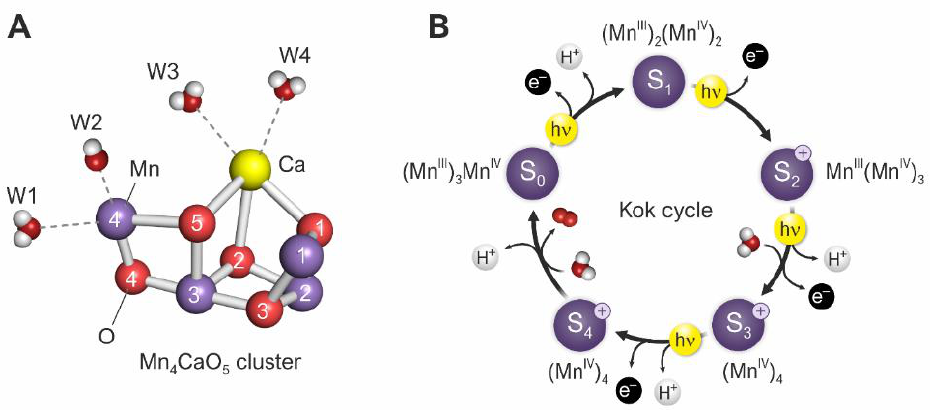
Figure 3. ( A ) The oxygen-evolving complex (OEC). The four manganese ions are colored violet, the six oxygen atoms are indicated in red, and the calcium atom is indicated in yellow. W1 to W4 are water molecules. ( B ) The Kok cycle (also called the Kok–Joliot cycle). S 0 to S 4 are the OECs in various states, without or with a positive charge, with oxidation states of the manganese indicated. Yellow circles labelled h ν indicate quanta from light. When S 2+ changes to S 3+ , a water molecule is taken up, and an electron and a proton are released. When S 3+ changes to S 0 , a water molecule is taken up, and a proton and an oxygen molecule are released. In darkness, the equilibrium state is mainly S 1 . Graphics by D. Shevela (SciGrafik, Sweden).